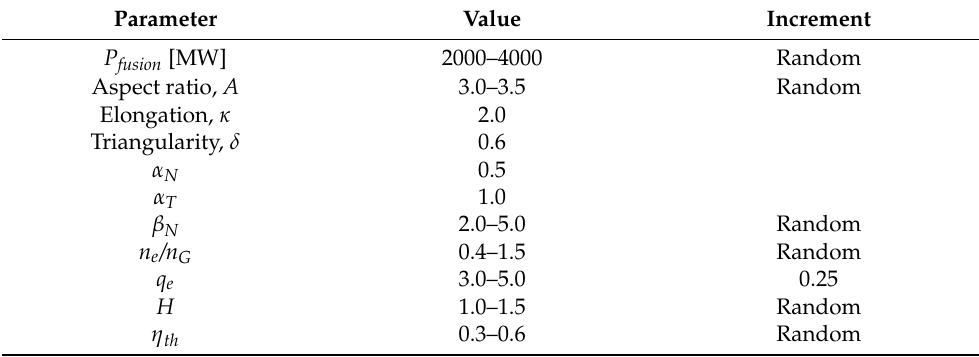
Table 1. Range of system parameters.